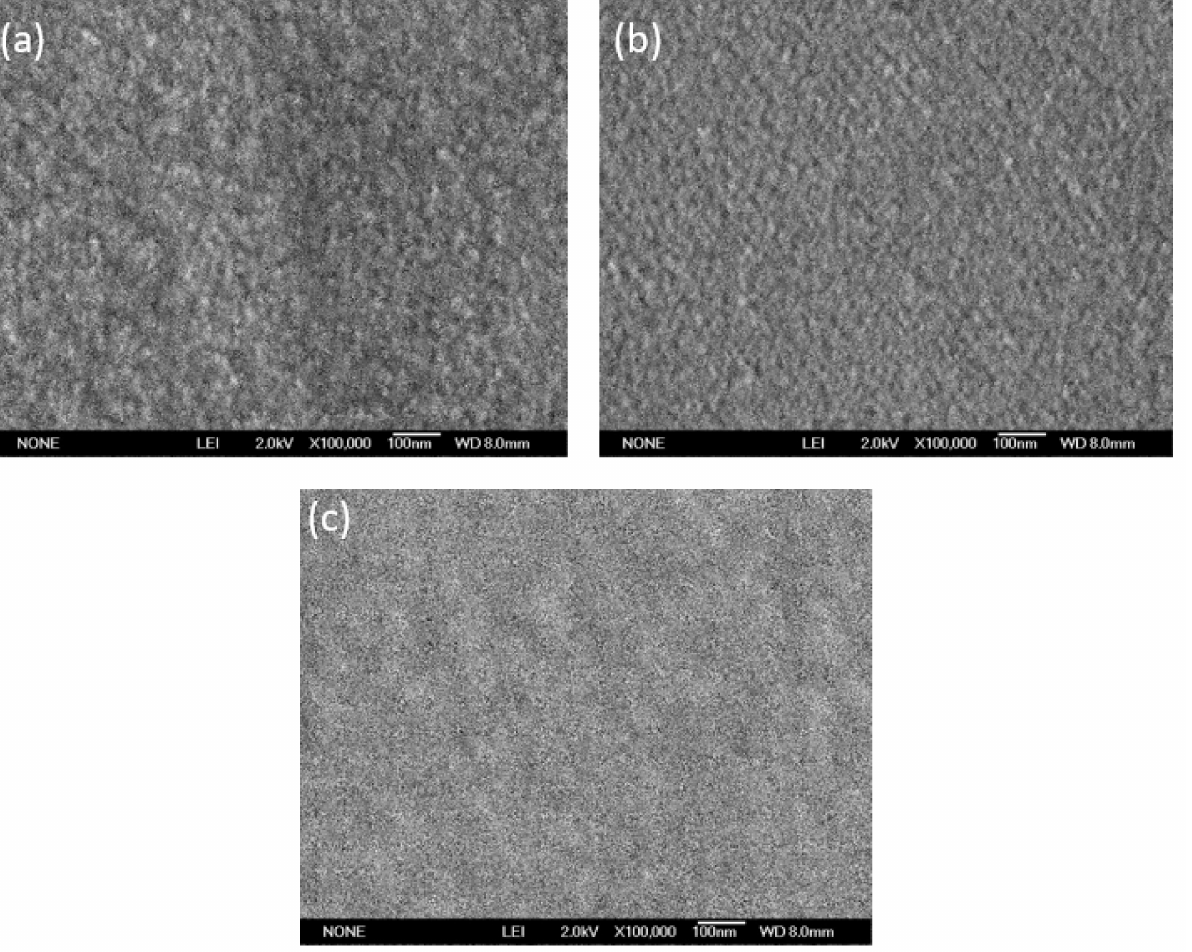
Figure 7. SEM pictures of: ( a ) sample 5TiO 2 -9SiO 2 ; ( b ) sample 7TiO 2 -9SiO 2 ; ( c ) sample 9TiO 2 -9SiO 2